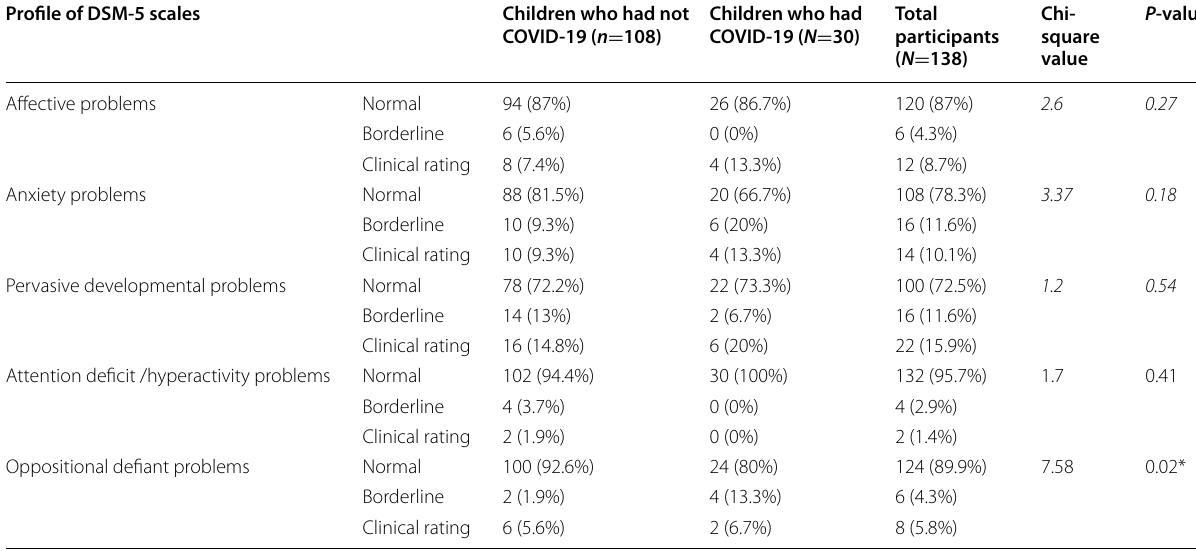
*Significant p value